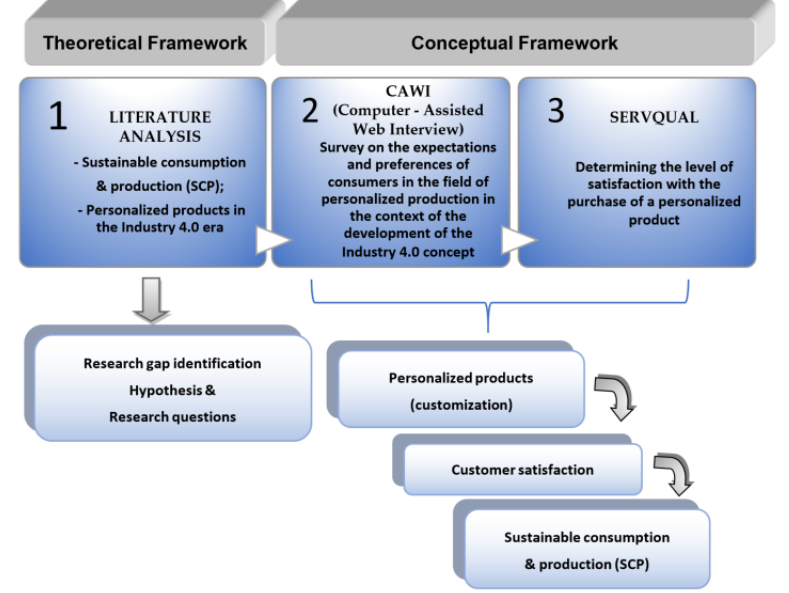
Figure 1. Theoretical and conceptual framework of research. Source: own study.